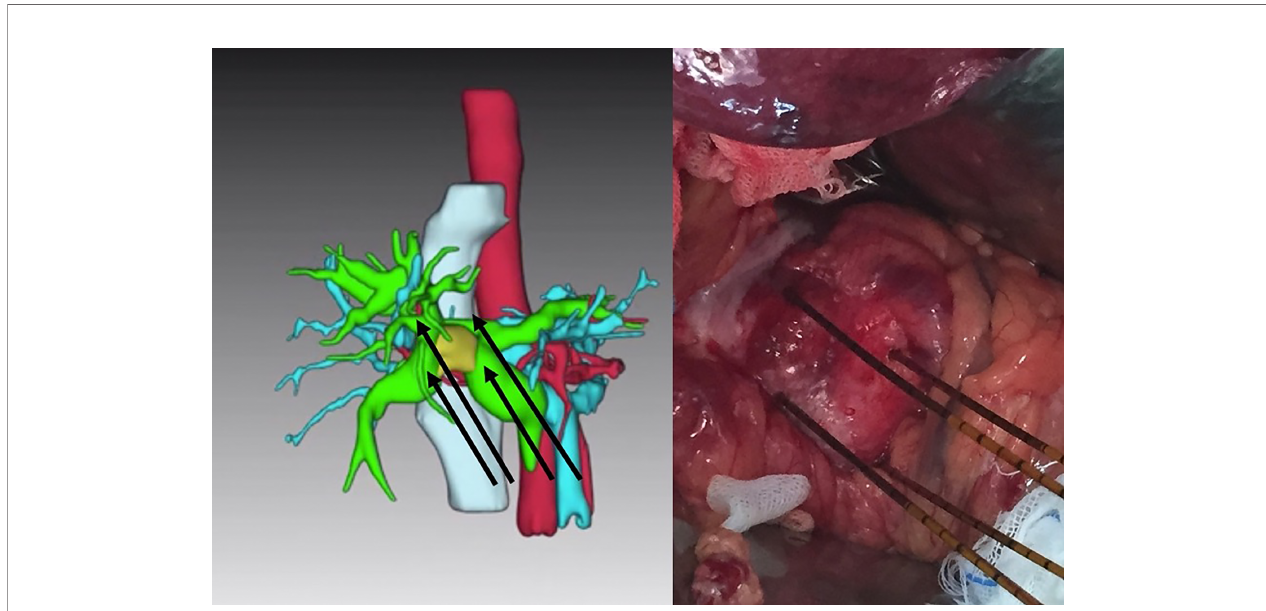
FIGURE 1 | Four electrodes placed parallel to the hepatoduodenal ligament to embrace the tumor (yellow target in left image) in a caudal to cranial direction for the treatment of unresectable Bismuth type IIIA perihilar